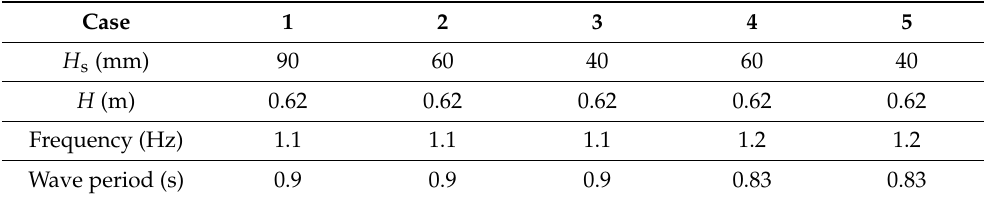
Table 3. Properties of generated